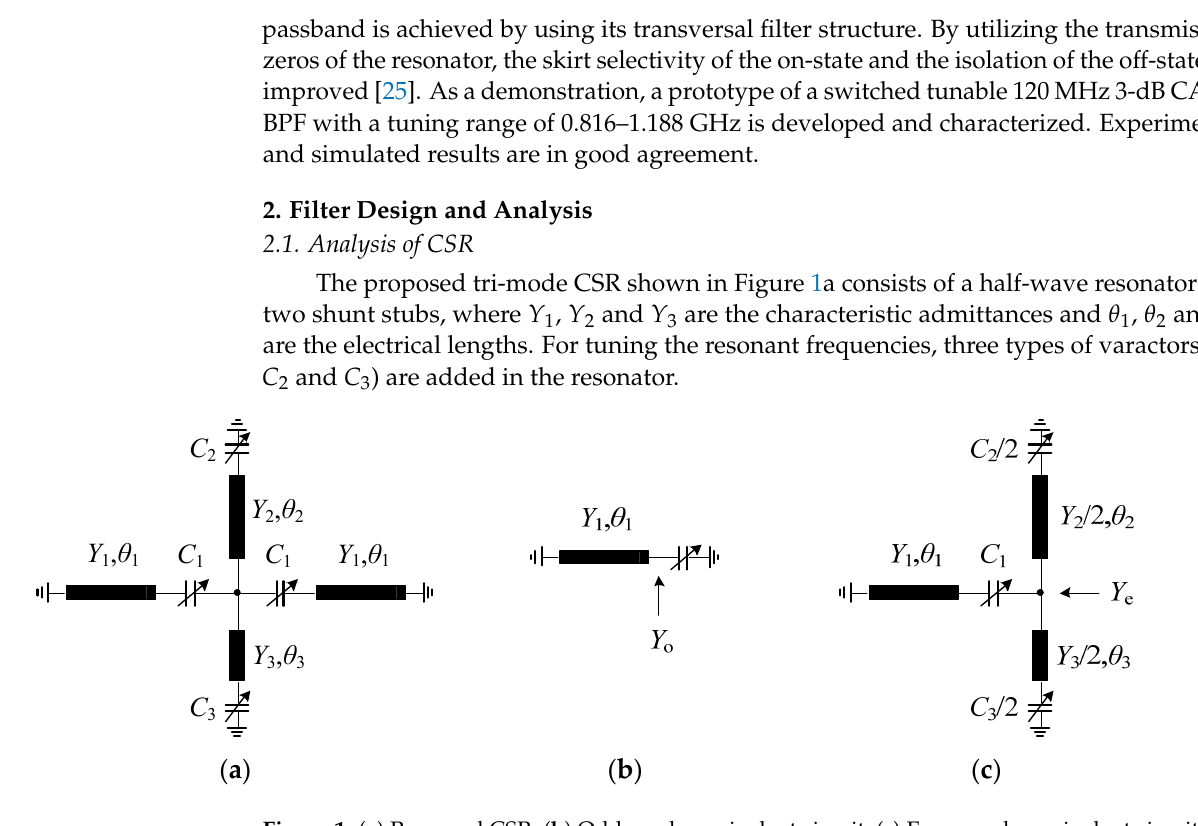
Figure 1. ( a ) Proposed CSR; ( b ) Odd-mode equivalent circuit; ( c ) Even-mode equivalent circuit.